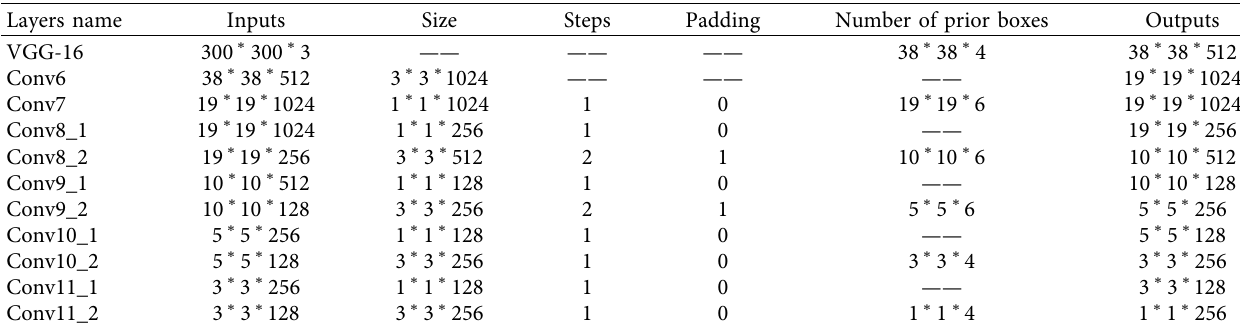
Figure 6: Model framework. Table 1: Related parameters in SSD.